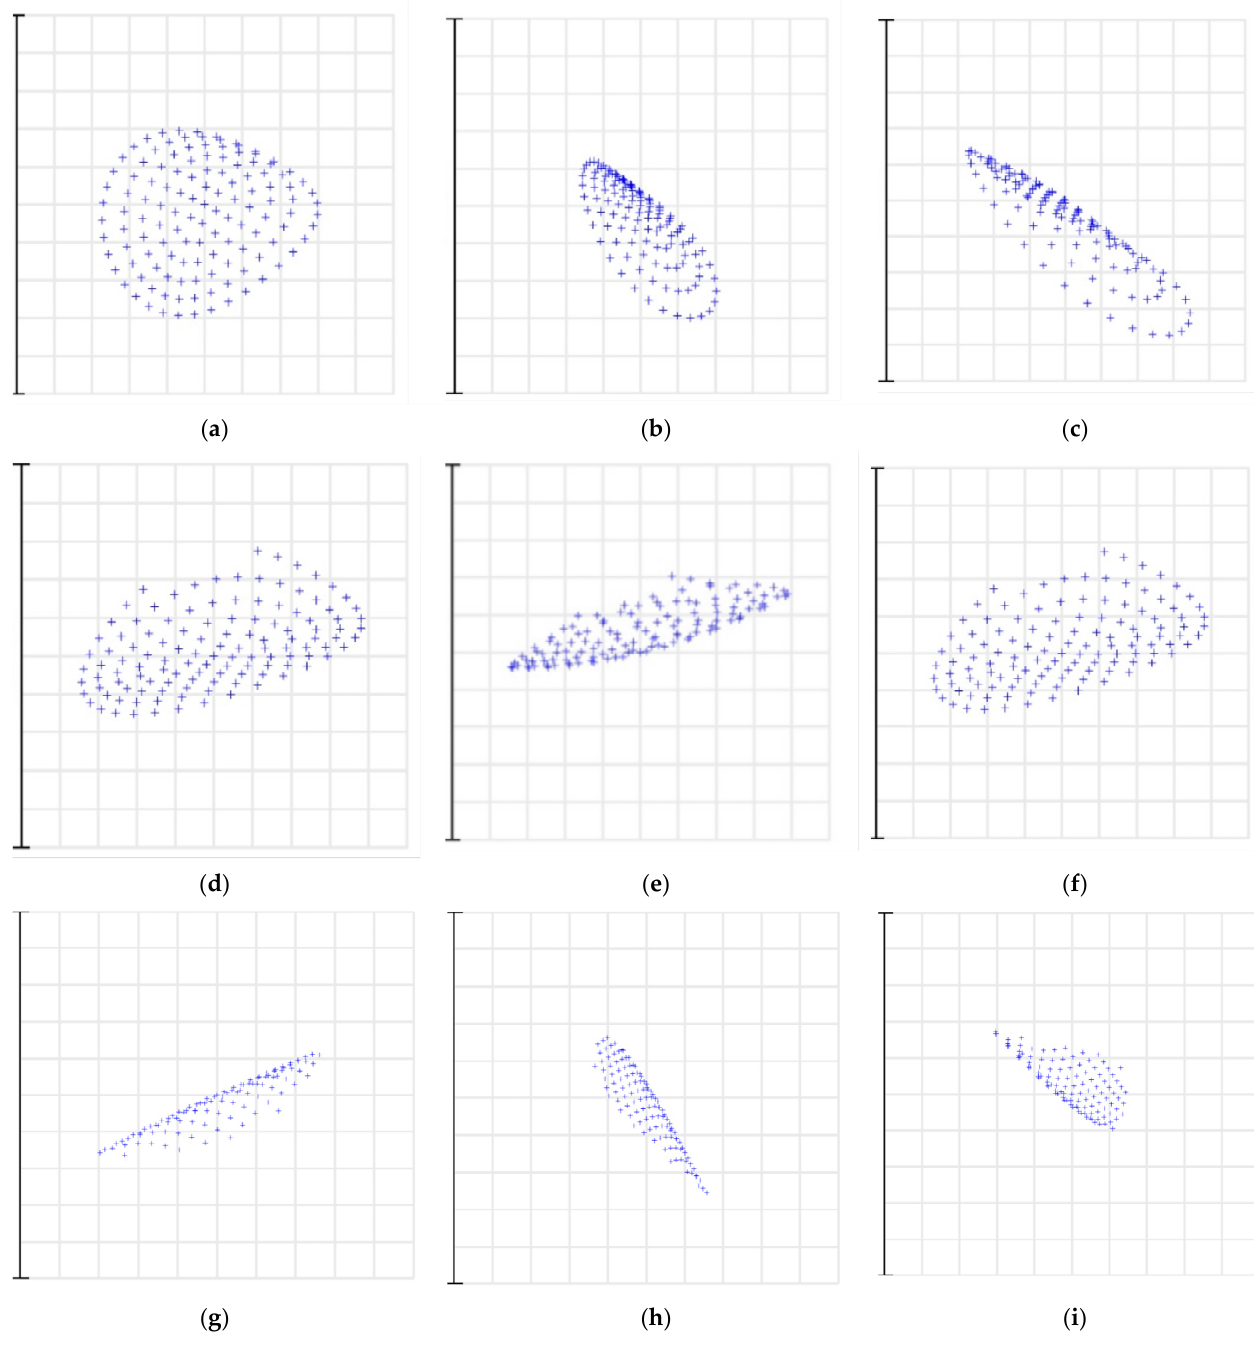
Figure 19. Spot diagrams corresponding to different diffraction orders. Figure 18. Spot diagrams corresponding to different diffraction Table 6. RMS and spectral resolution of multiple configurations.